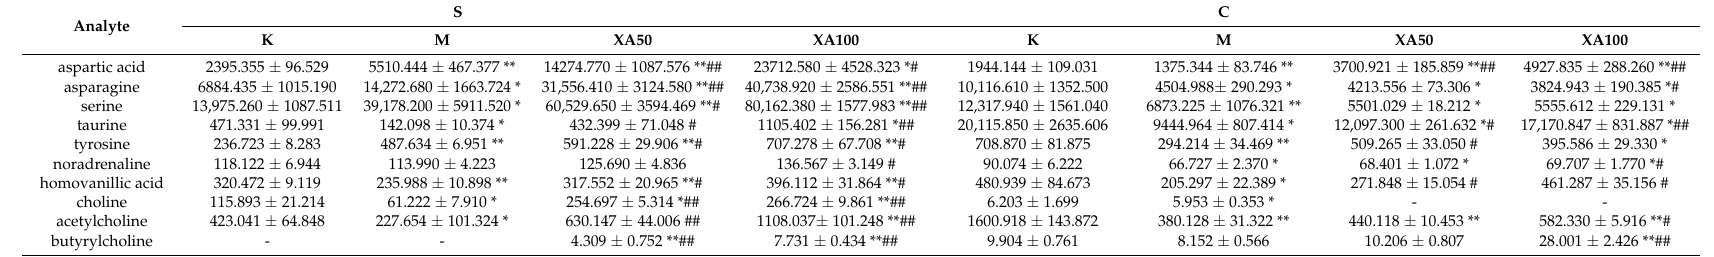
Table 5. Results of absolute quantification of neurotransmitters in cell supernatants and cells (ng).